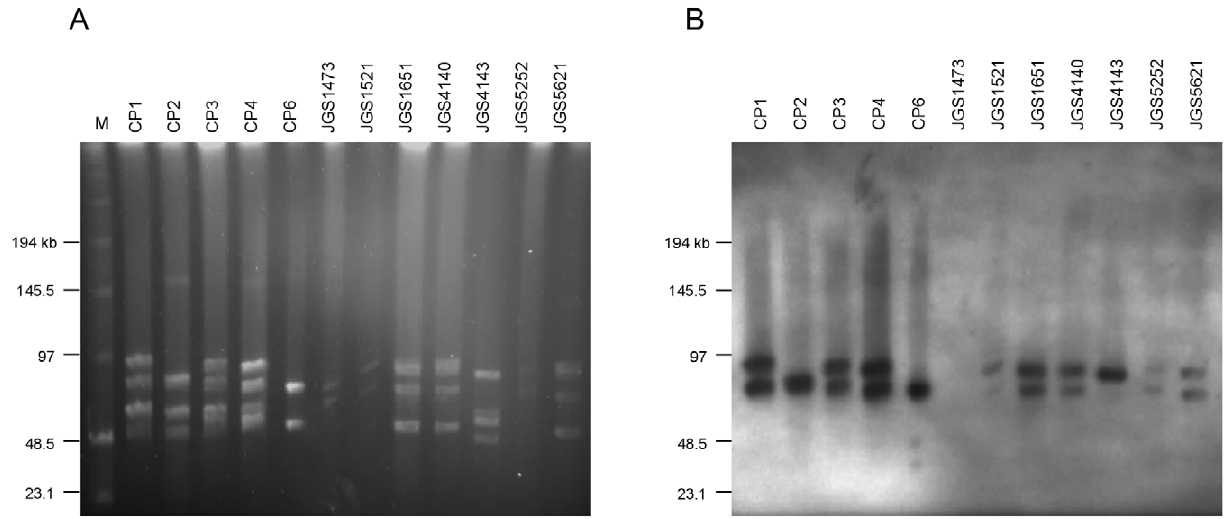
Figure 3. PFGE and Southern blot analyses of plasmids from C.perfringens poultry strains. (A). Agarose plugs containing DNA isolated from the eight sequenced poultry strains were digested with NotI and subjected to PFGE. (B). Southern blotting was performed with DIG-labelled probes for netB and hdhA . Results from both netB and hdhA probes are shown overlayed. In all lanes with two bands, the upper band represents netB and the lower band hdhA . Both probes hybridized to the same band in CP2. In CP6, only the hdhA probe hybridized, while in JGS4143, only the netB probe hybridized.